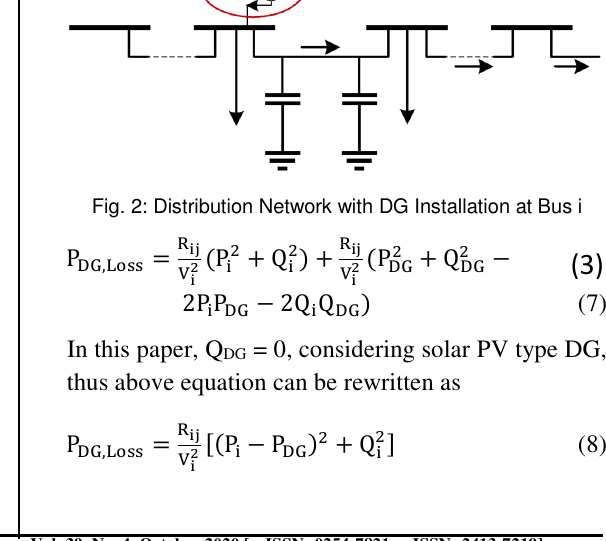
Fig. 1: One Line Diagram of Distribution System